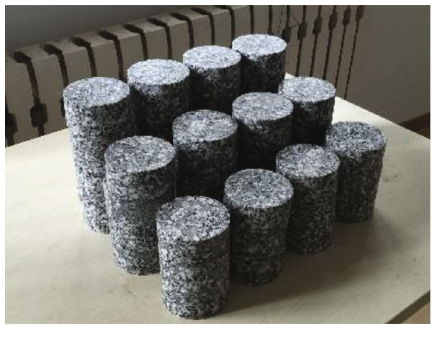
Figure 1: Prepared granite specimen. Table 1: Basic physical parameters of